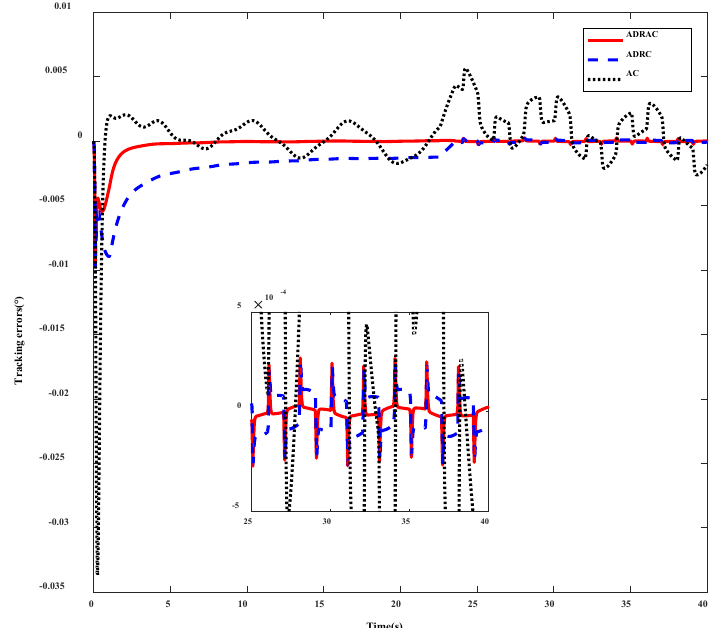
Figure 4. The tracking errors of the three controllers.